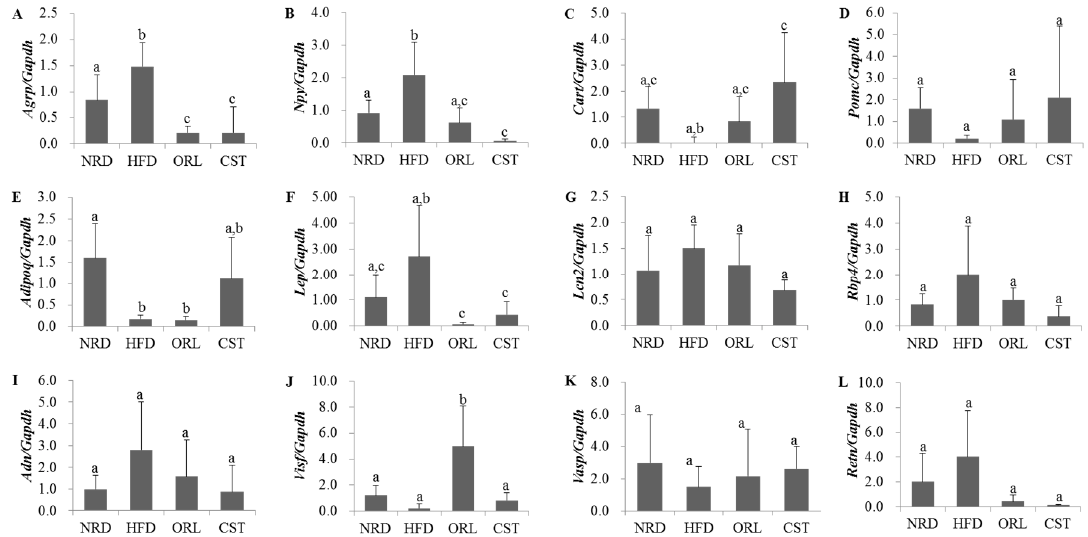
Figure 4. Expression levels of neuropeptides and adipokines: ( A – D ) Gene expression levels of neuropeptides in hypothalamus ( n = 6); ( E – L ) Gene expression levels of adipokines in adipose tissues ( n = 3). Levels of mRNAs were measured by qRT-PCR and the fold values were normalized using the house keeping gene Gapdh . Data represented as mean ± SD ( n = 3–6). Different letters above bars indicate significant difference from each other at p < 0.05 as determined by one-way ANOVA with Least Significant Difference (LSD) post hoc test.